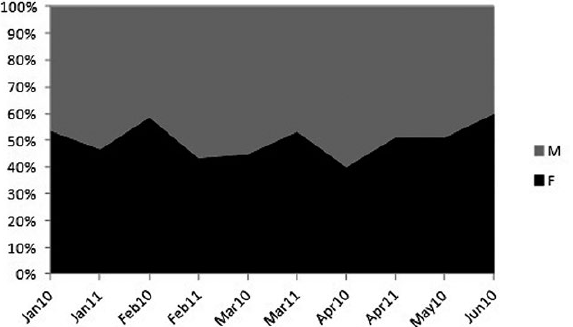
Fig. 2. – Relative frequency (%) of sexes during the study. χ 2 -test, P >0.05 (M, male; F,